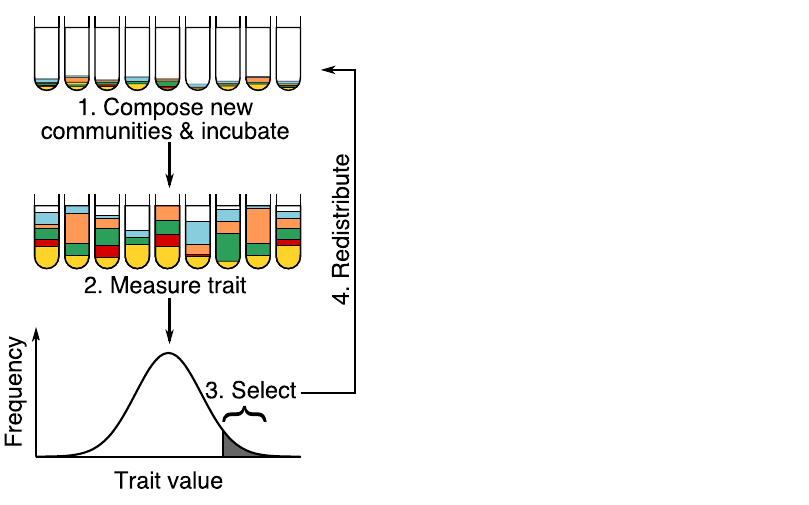
Fig 1. Multiple microbial communities are created and incubated in parallel (colors represent different species or lineages, and white space represents cell-free growth medium) for a given amount of time as cells grow and divide. Then, the trait value of each ecosystem is measured, communities are ranked, and the best communities are redistributed at a reduced initial population size to make a new selection round. Communities do not necessarily start with the same biomass or reach the same biomass after incubation. There are many ways to implement selection and redistribution. Figure adapted from [6] .